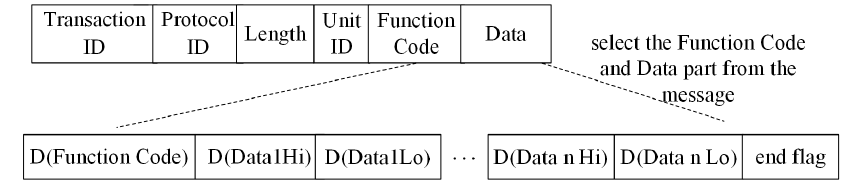
Figure 6. The construction of learning messages and the conversion process of data values in Modbus TCP.